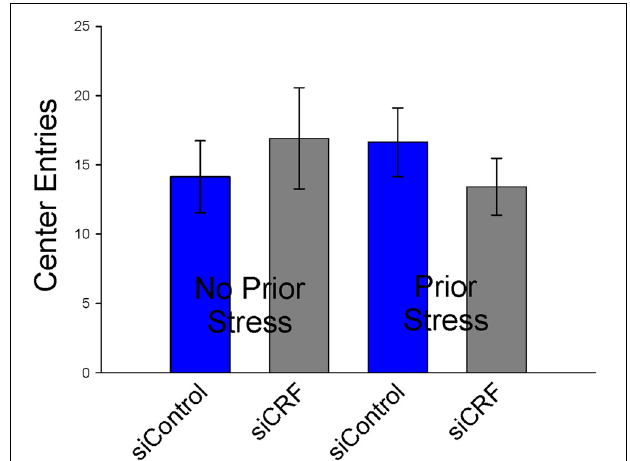
FIGURE 5 | Plasma corticosterone values after open field. Treatment with siCRF and prior restraint had no significant effect on the increase in plasma corticosterone induced by OF testing ( p < 0 . 001).